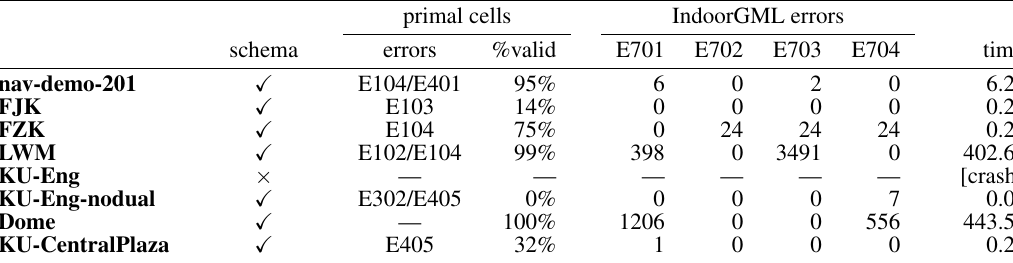
Table 2. Validation overview.